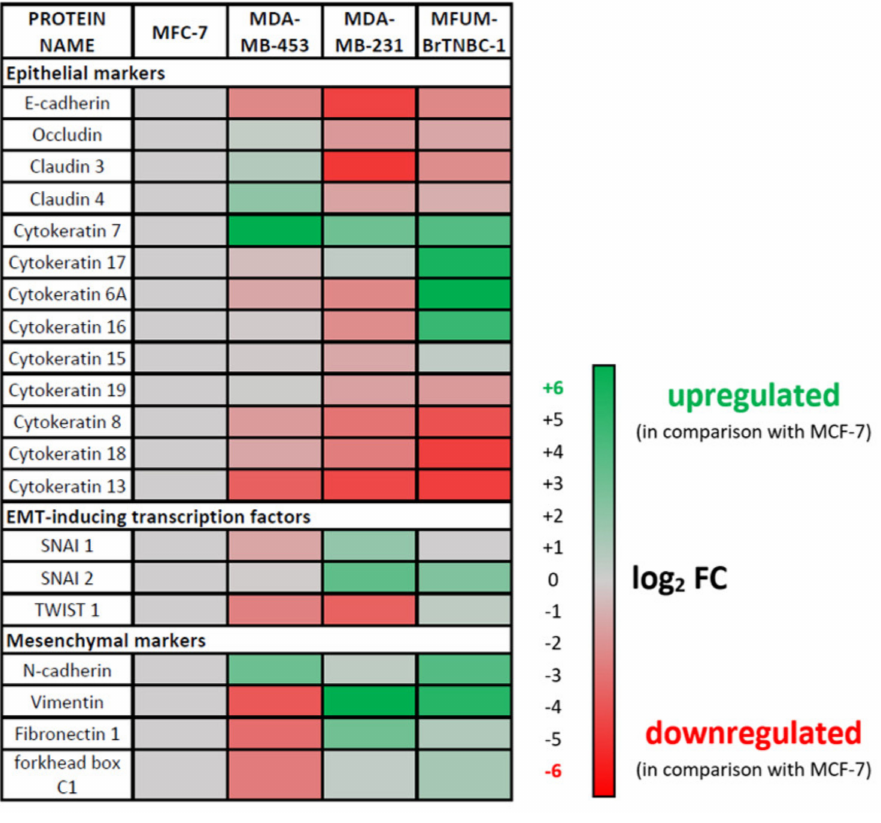
Figure 6. Expression of epithelial–mesenchymal transition (EMT) markers in MFUM-BrTNBC-1, MDA-MB-453 and MDA-MB-231 compared to